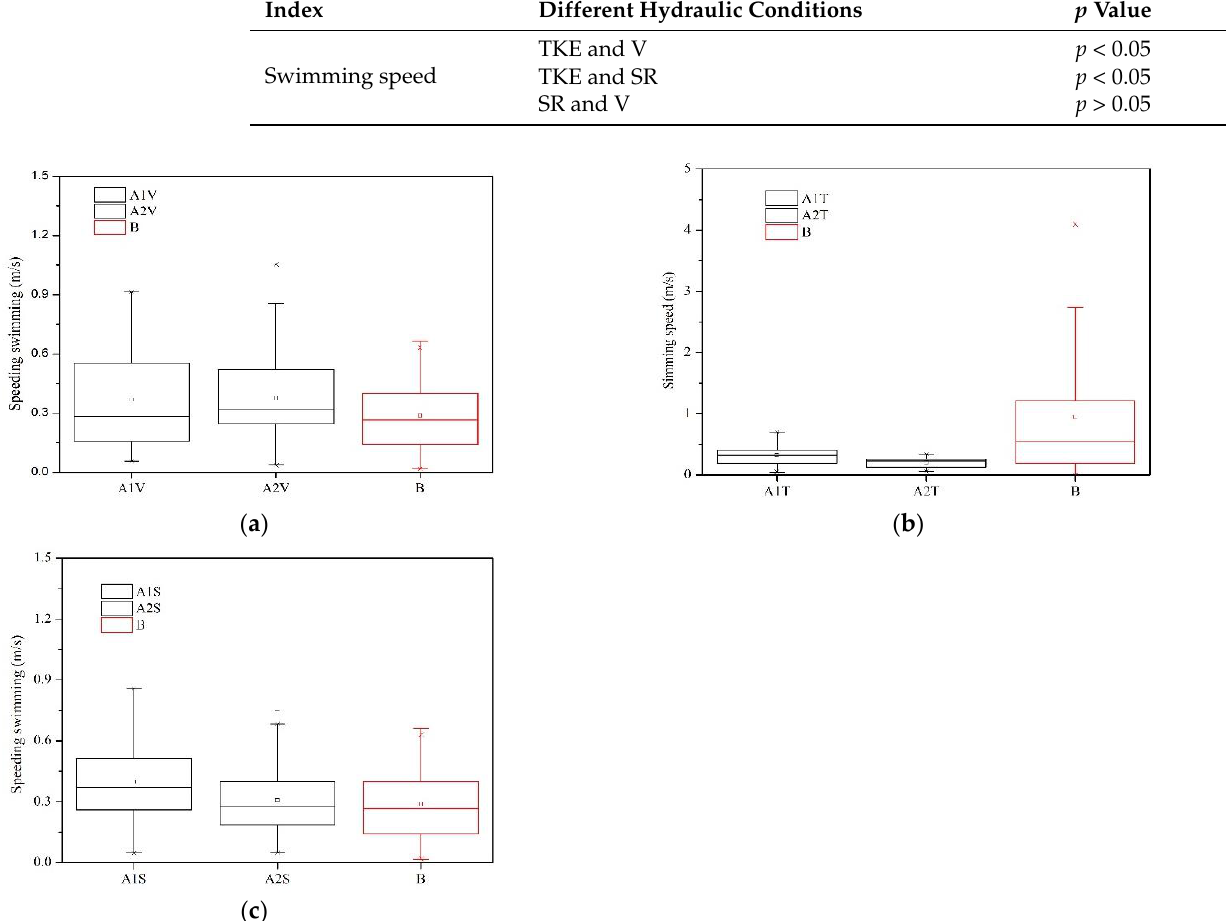
Figure 6. The magnitude of fish swimming speed under typical hydraulic conditions: ( a ) high velocity zone, ( b ) high TKE zone, and ( c ) high SR zone (Note: the black trajectories represent fish passing through high V (trajectories A1V, A2V), TKE (trajectories A1T, A2T) and SR (trajectories A1S, A2S) zones, the red trajectory represents fish not passing through the above-mentioned high zones).